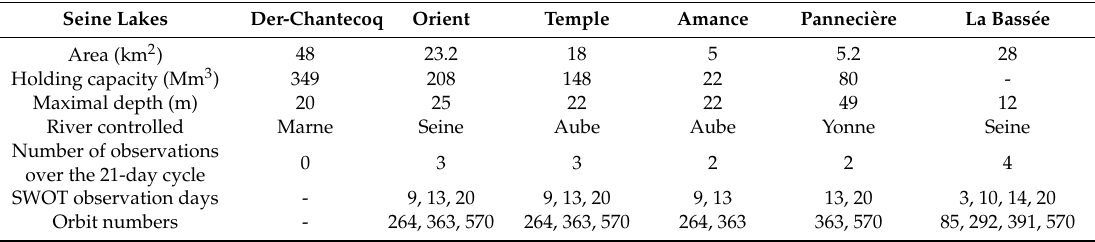
Figure 1. The Surface Water and Ocean Topography (SWOT) swaths over the Seine reservoirs and over the La Bassée region. The rivers and water bodies were extracted from the cartographic Carthage database (https://geo.data.gouv.fr/fr/datasets). The location of the five reservoirs studied and T6G2 gravel pit is highlighted. The same color code is used for the two maps. Table 1. Key parameters of the five reservoirs of the Seine river and the La Bass é e zone studied. Seine